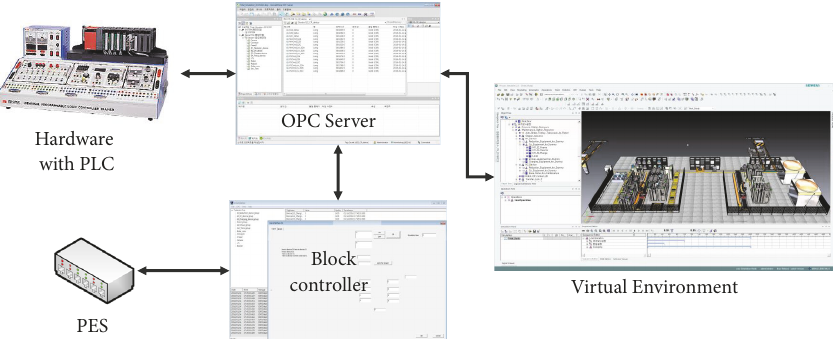
Figure 7: Hardware-in-the-loop simulation system for pyroprocessing automation